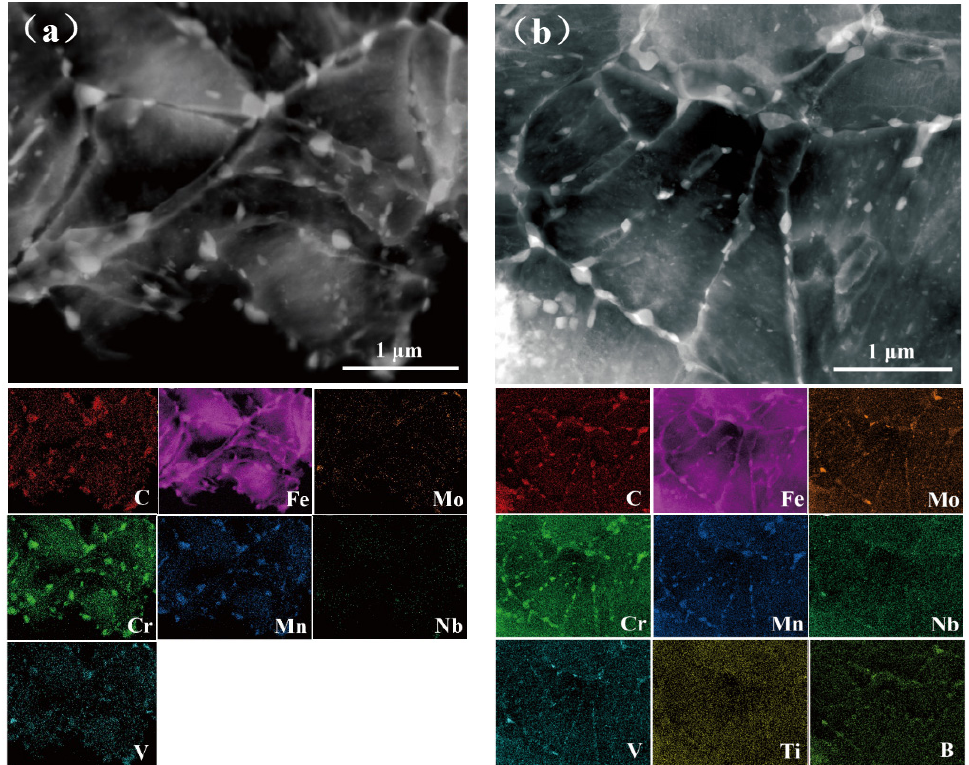
Figure 6. HAADF STEM images and corresponding EDXS mappings of ( a ) TB0 and ( b ) TB1 steels.